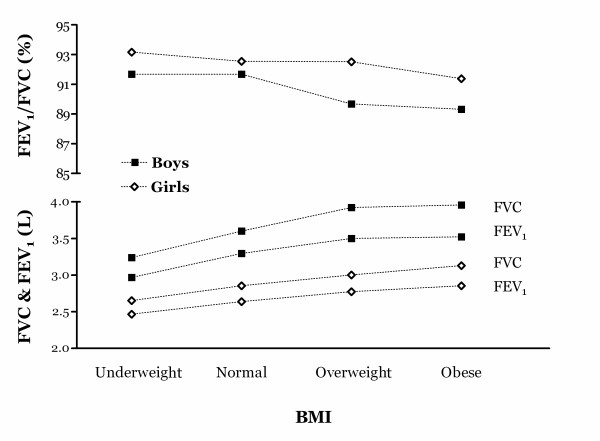
Baseline spirometric lung functions stratified by sex and body mass index (BMI). All of three spirometric lung functions were significantly different across BMI categories (p < 0.05). FEV1, forced expiratory volume in one second; FVC, forced vital capacity